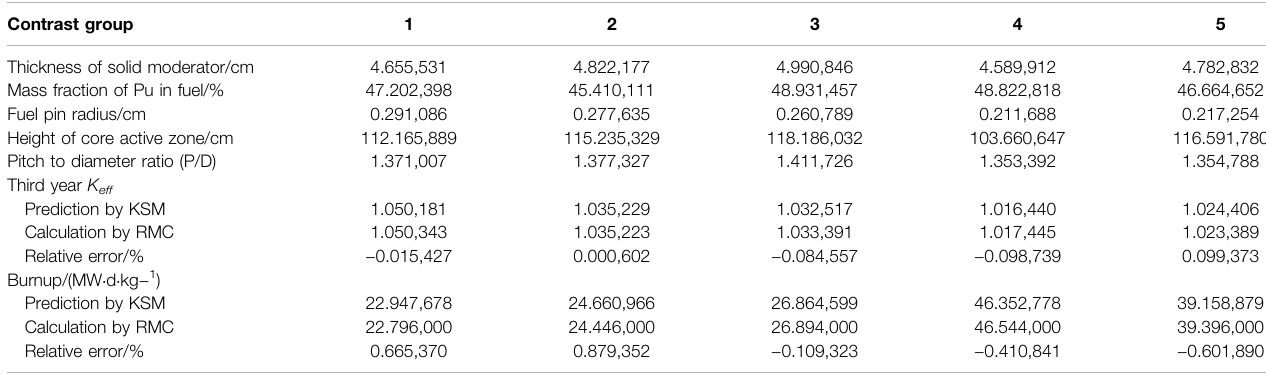
TABLE 4 | Accuracy veri fi cation results of KSM for predicting K eff and burnup. Contrast group